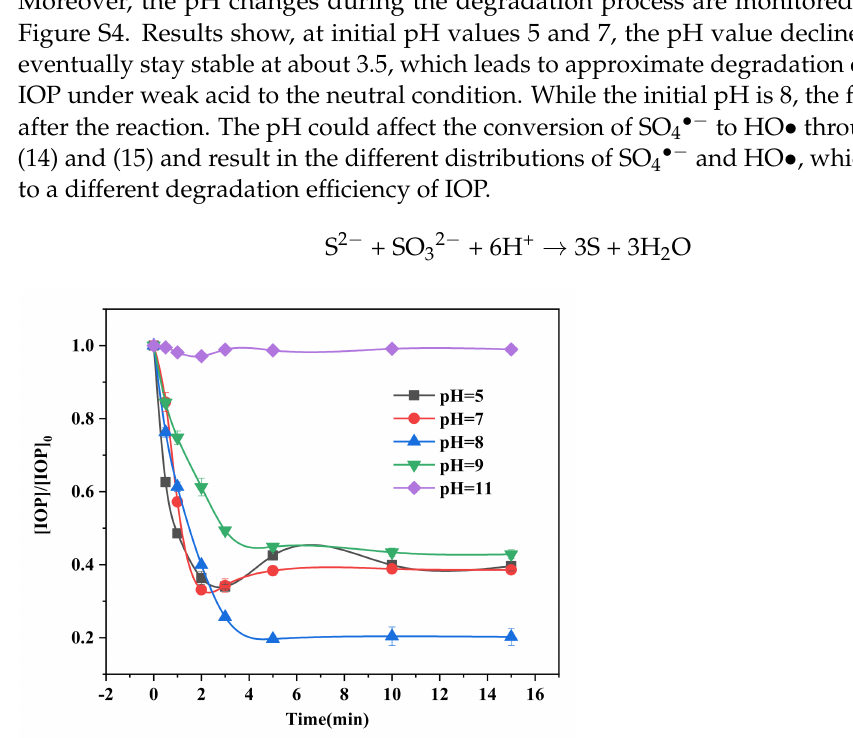
Figure 3. Effects of pH on the degradation of IOP by FeS/sulfite system.